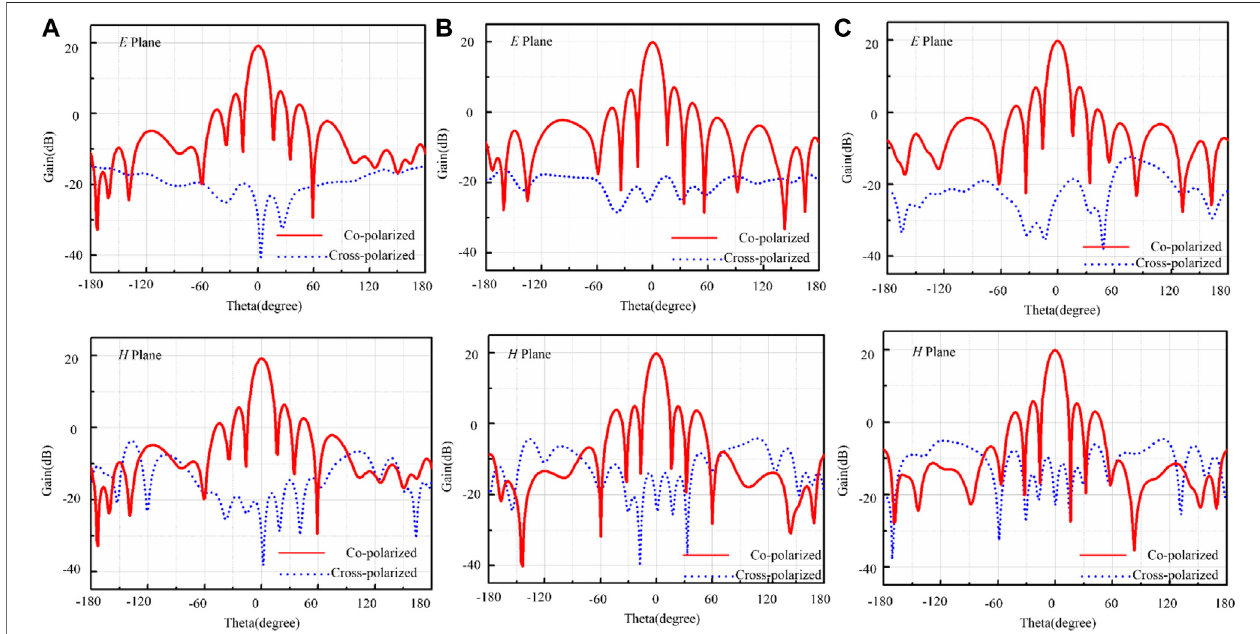
FIGURE 7 | Simulated radiation pattern of the metasurface. (A) 7.1 GHz, (B) 7.3 GHz, and (C) 7.5 GHz.